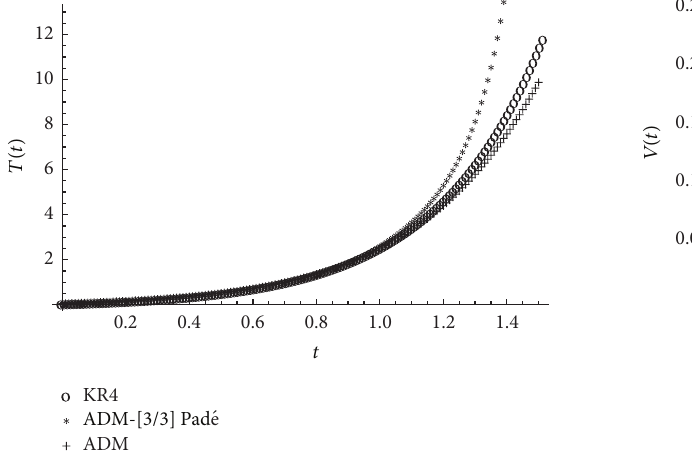
Figure 3: Curves of KR4, ADM-[3/3] Pad´e approximation, and ADM for 𝑉(𝑡) .